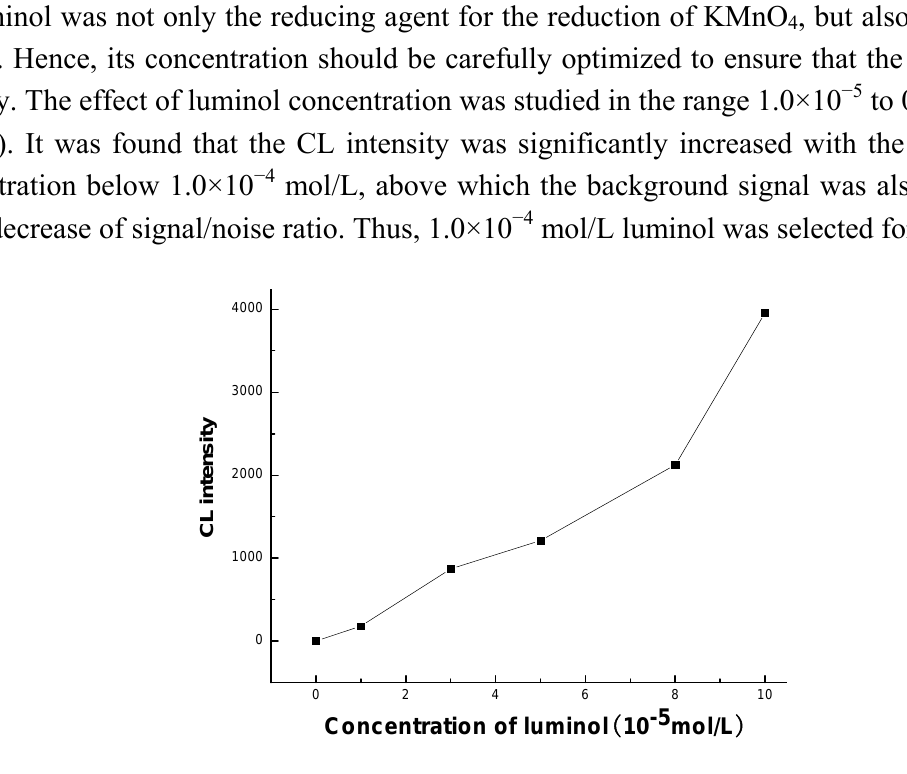
Figure 5. Effect of luminol concentration on CL intensity (sample = 6